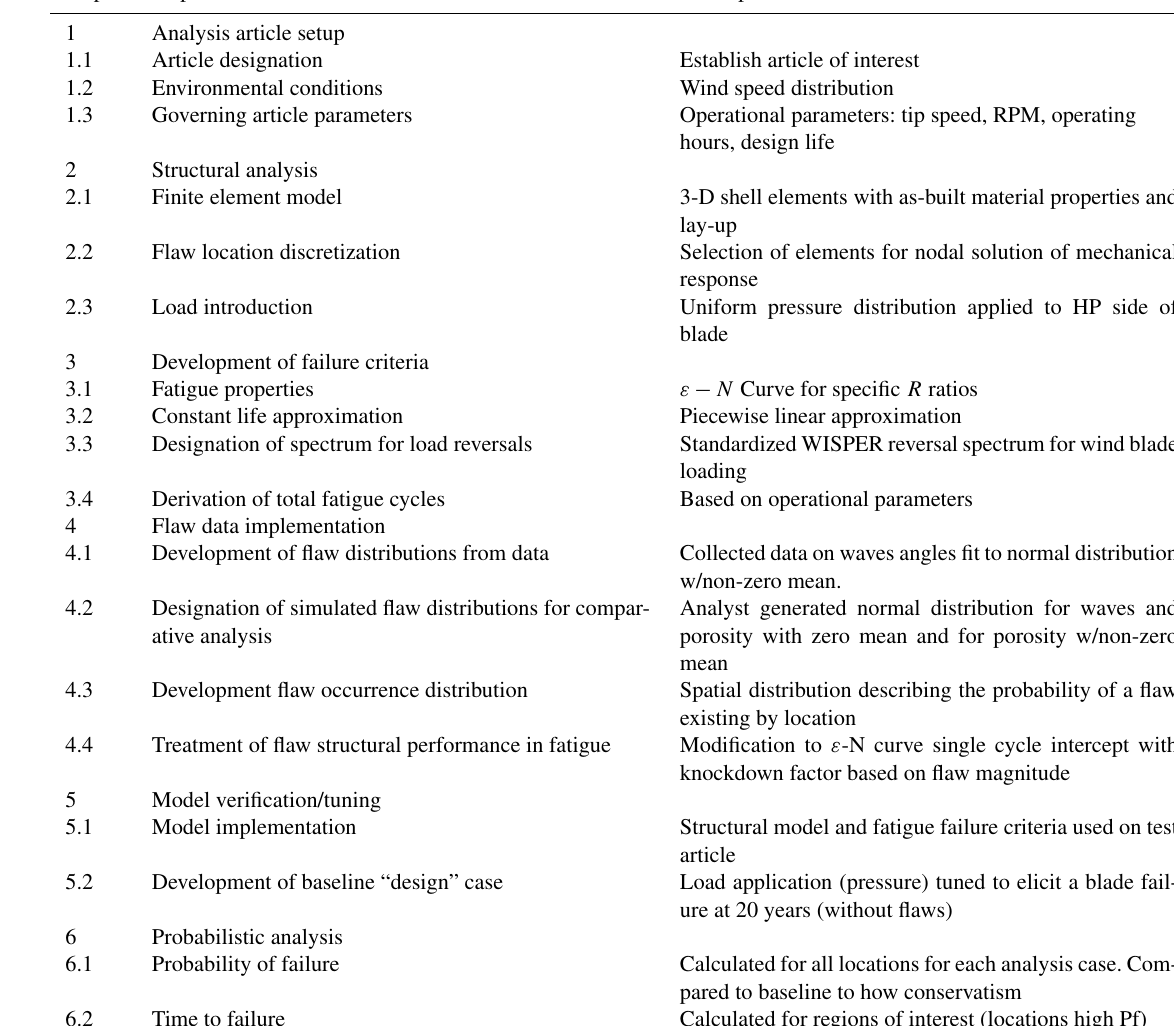
Table 1. Structural reliability analysis